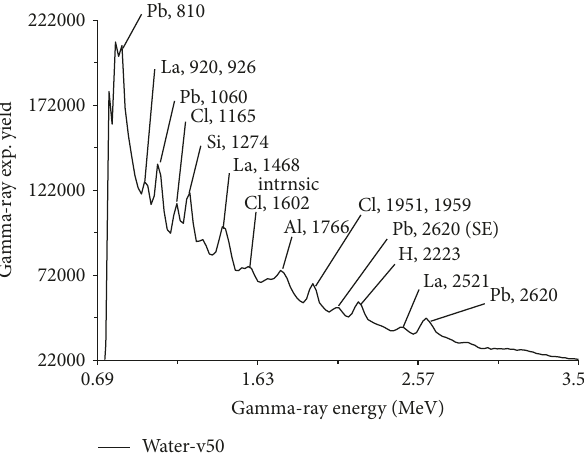
Figure 2: Prompt gamma-ray spectrum due to activation of the LaCl3:Ce detector caused by the capture of thermal neutrons in La, Ce and Cl in LaCl3:Ce detector material over 0.69 – 3.51MeV